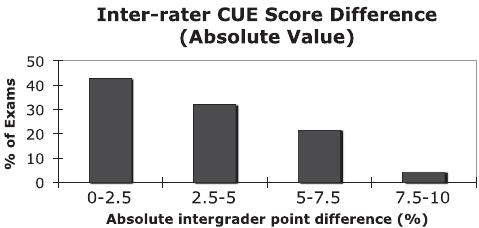
FIG. 3. Absolute value grader differences in ‘‘total CUE score’’ for a total of 47 exams graded in common by independent graders using a common rubric. Categories are exclusive of the lowest number in the bin except for the lowest bin: E.g.,